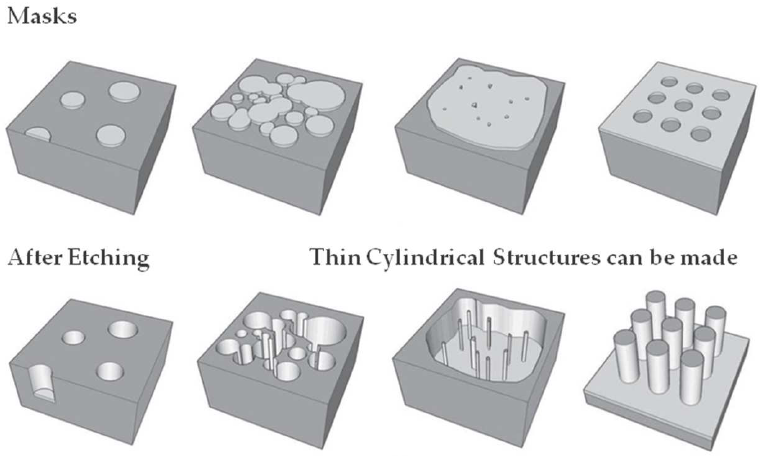
Figure 9. Comparison of technologies based on the proposed CSDG MOSFET model.